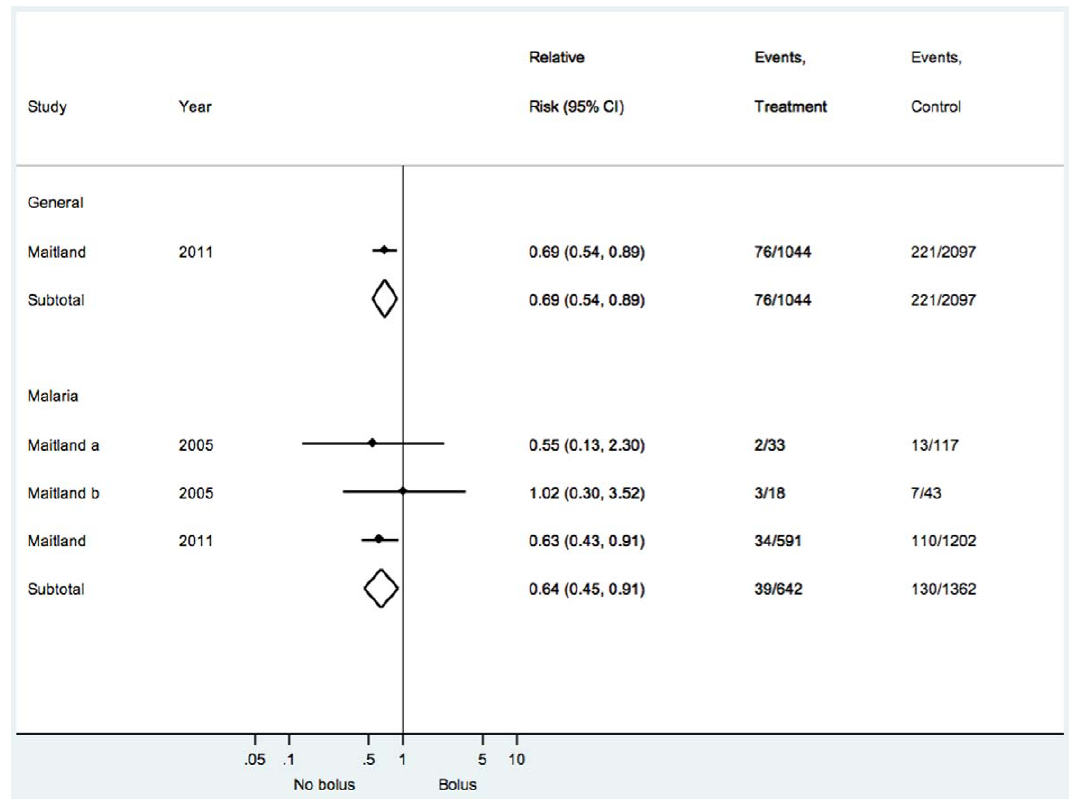
Figure 2. Forest plot for the outcome of mortality comparing no bolus and bolus.